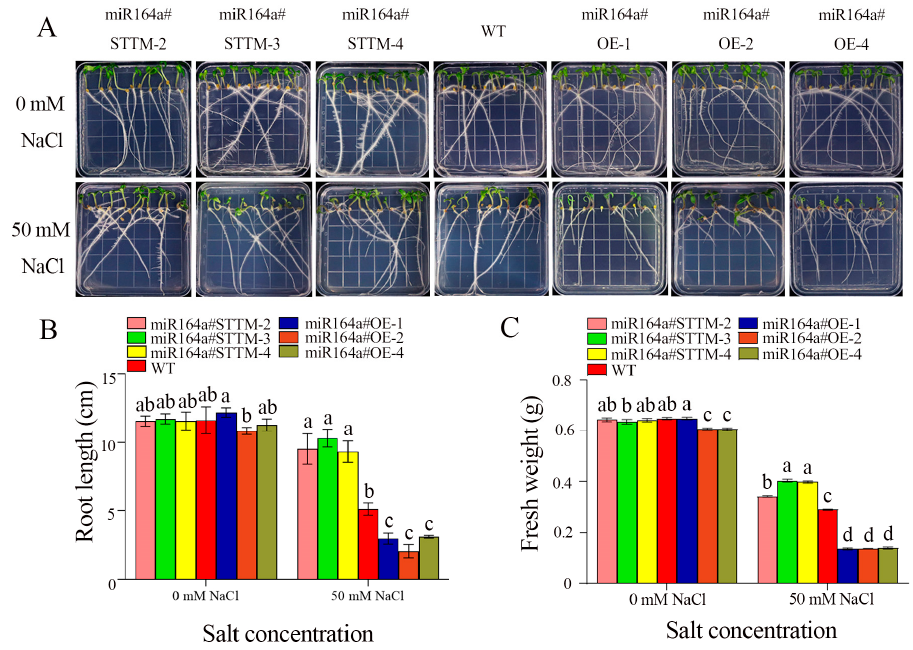
Figure 1. Comparative analysis of miR164a#STTM, WT and miR164a#OE tomato seed germination under salt stress. ( A ) Germination of miR164a#STTM, WT and miR164a#OE tomato seed in a medium containing 50 mM NaCl. ( B ) Root length of miR164a#STTM, WT and miR164a#OE tomato seed under salt treatment. ( C ) Fresh weight of miR164a#STTM, WT and miR164a#OE tomato seedlings under salt treatment. Vertical bars represent standard deviations of the means, n = 3. Different letters indicated significant differences between WT and transgenic tomatoes in the values at p < 0.05.